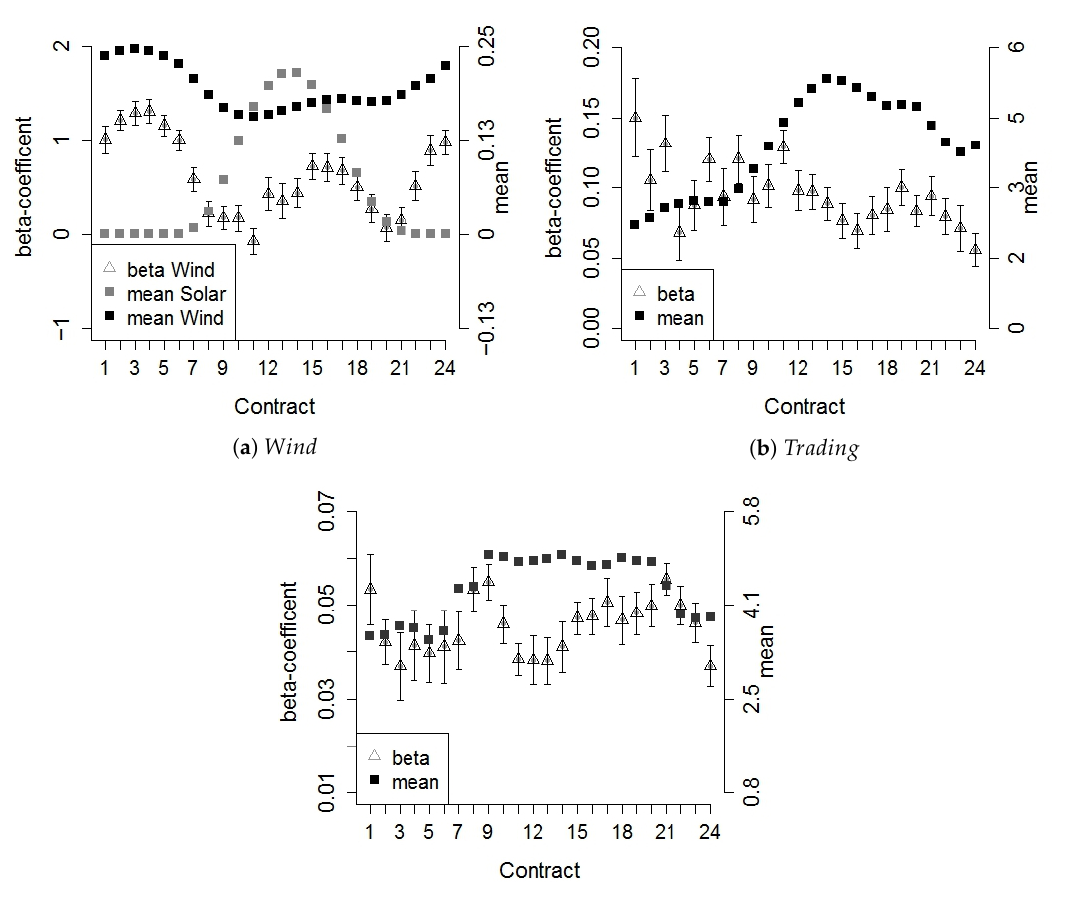
Figure 5. Regression β -coefficients (left axis) for the volume-weighted average standard deviation VSD as the dependent variable, with standard errors, plotted against the corresponding mean (right axis) of the variables separately for the individual hourly contracts. Subfigure ( a ) shows Wind as the relative wind share of the total consumption (together with the relative solar share of the total consumption Solar ). Subfigure ( b ) shows Trading as the traded volume of the intraday market in GWh, and Subfigure ( c ) shows ∆ Price as the absolute price difference of the day-ahead auction price and the volume-weighted average price of the intraday market. Significant influence of Wind coincides with the highest share of wind energy in the overall mix. Trading and ∆ Price were always significant regardless of fluctuating